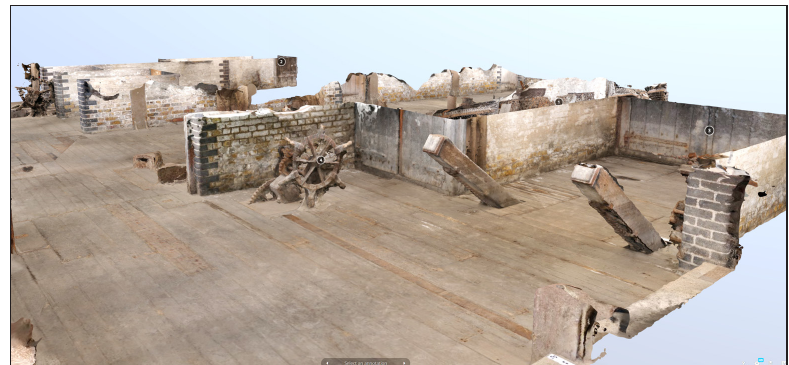
Figure 2: Ground floor of the House Mill photogrammetrically modelled and annotated to allow virtual tours (Photo: Gai